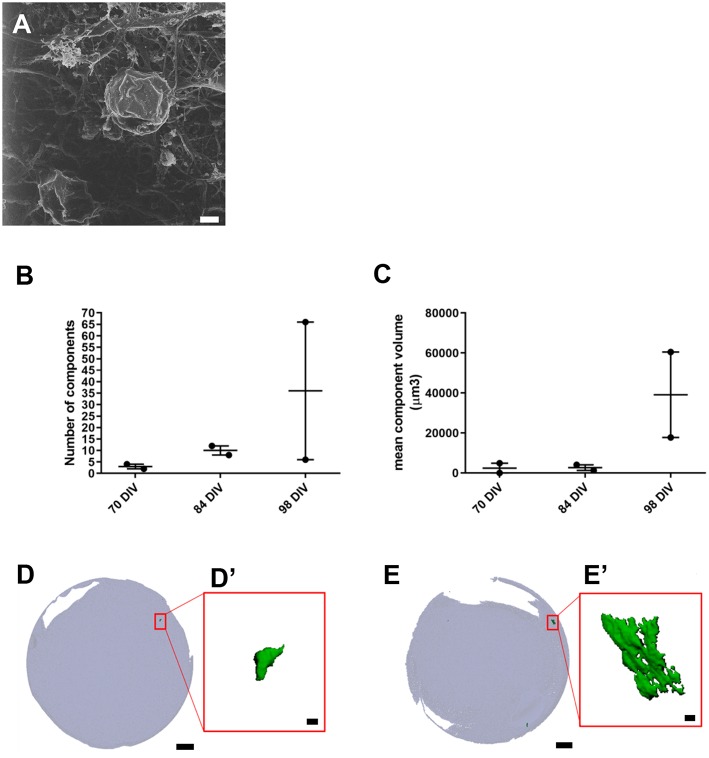
Presence of inner ear crystalline structures in RCCS-derived organoids. (A) HIM image of organoid at 98 DIV shows the presence of a filamentous membrane covering the surface of organoid (arrow and otoconia-like structures (arrowhead). (B–E) Micro-computed tomography of organoids reveals the presence of mineral components suggestive of otoconia. Total component volume (B) and mean component volume (C) of organoids at 70, 84, and 98 DIV (n = 2 at each timepoint). Data shown as mean with range and individual values plotted. Representative micro-CT images of whole organoid scan at 70 DIV (D) and 98 DIV (E) and magnified three-dimensional reconstructions (D',E') of one mineral component. Scale bars, (A) 2 μm, (D,E) 200 μm, (D',E') 10 μm.